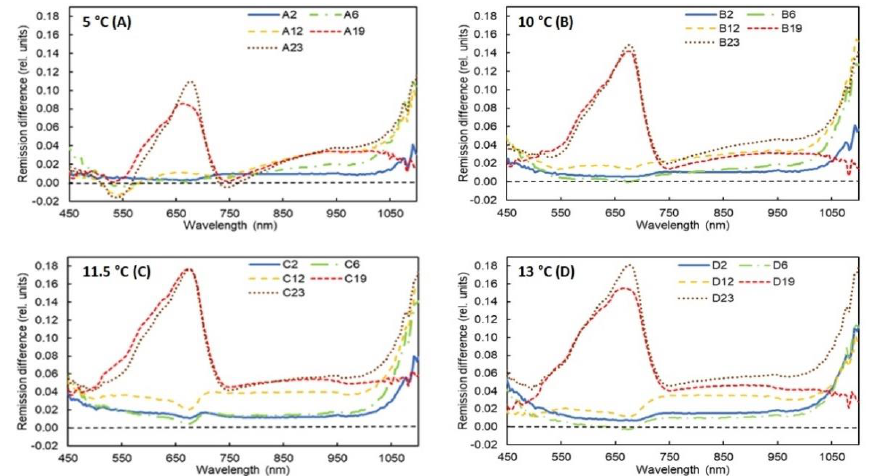
Figure 5. Differences of averaged remittance spectra (tec5 spectrometer) of the banana stored at the different temperatures (A: 5 °C; B: 10 °C; C: 11.5 °C; D: 13 °C; measured on days 2, 6, 12) and in shelf life (days 19, 23), and those of the untreated fruit on day 0.